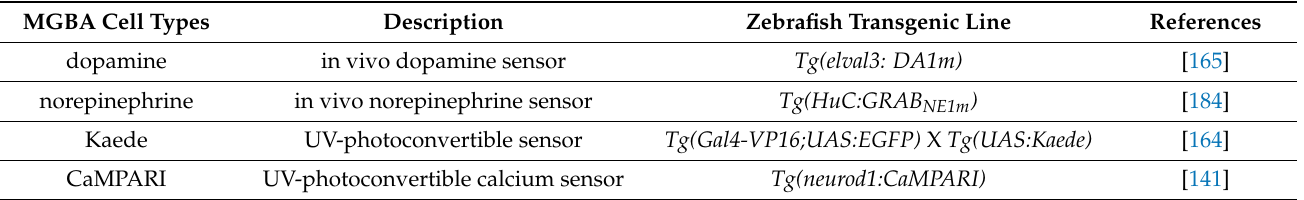
Table 3. Zebrafish transgenic reporter lines for neurotransmitter sensors and genetically modified fluorescent